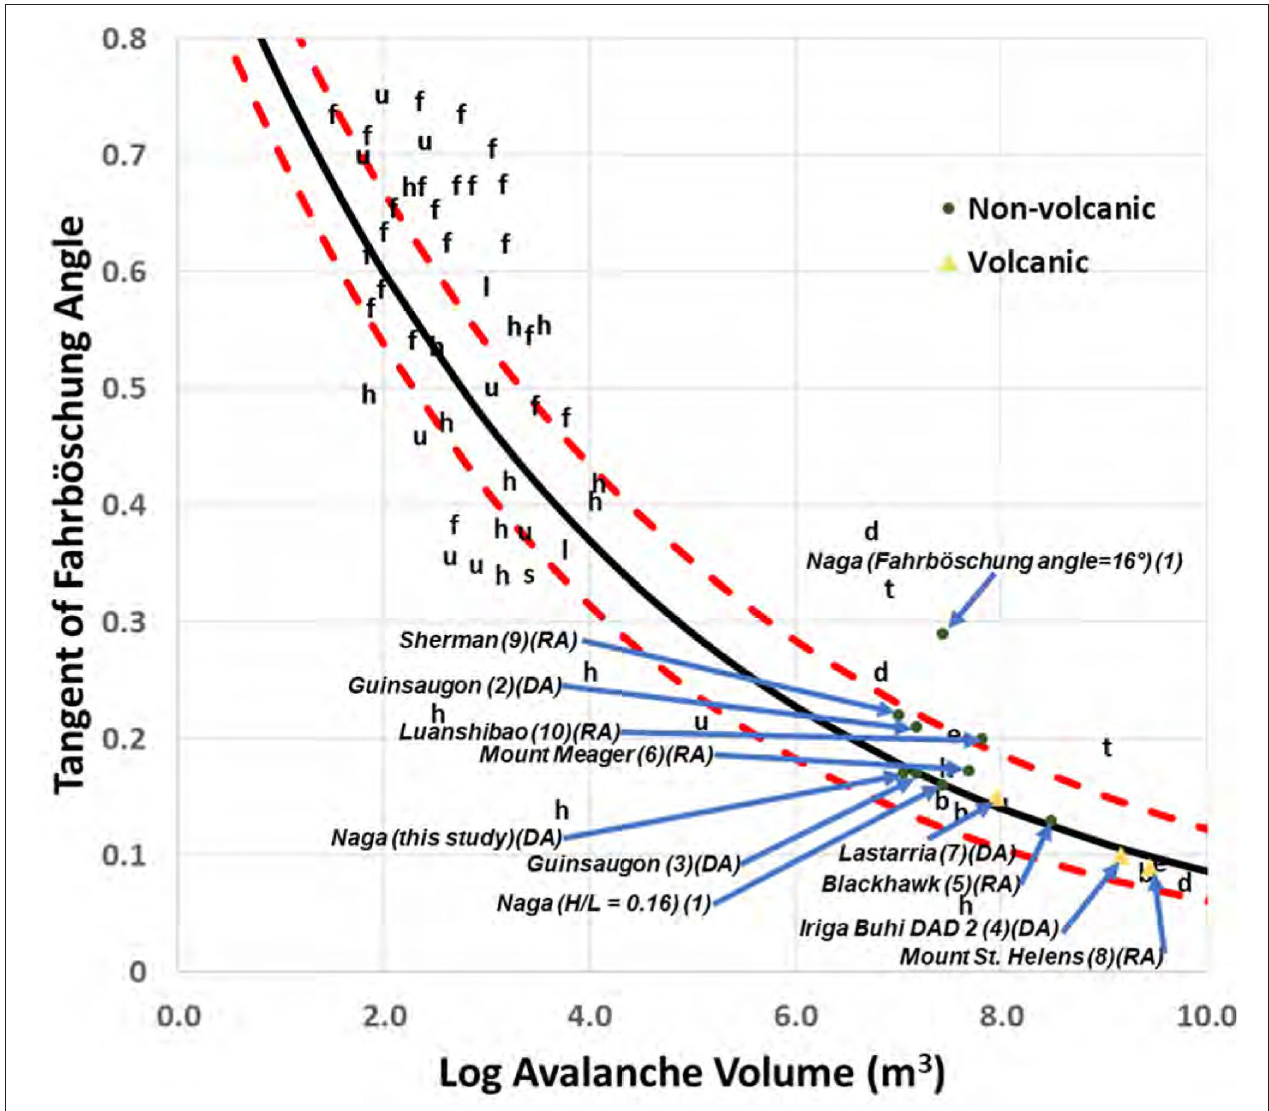
FIGURE 13 | Modified plot of debris flow and debris avalanche volume vs. tangent of reach angle for 71 events from Corominas (1996) and additional data. Labels correspond to the obstacles and topographic constraints of the path: f, dense forest: l, open forest; s, scree deposit; b, bends; d, deflections; t, toe thickening in a fan; h, channeling; w, opposing wall; u, unobstructed with free lateral extension. Black line represents the regression equation derived from the dataset whereas the red dashed lines show its corresponding upper and lower limits. Additional data are included to show how the Naga Landslide fits in the global context of debris and rock avalanches. References are as follows: (1) Catane et al., 2019, (2) Evans et al., 2007, (3) Lagmay et al., 2008, (4) Paguican et al., 2012, (5) Johnson, 1978, (6) Guthrie et al., 2012, (7) Naranjo and Francis, 1987, (8) Voight et al., 1983, (9) McSaveney, 1978, (10) Wang et al., 2018 whereas DA and RA stand for Debris Avalanche and Rock Avalanche ,